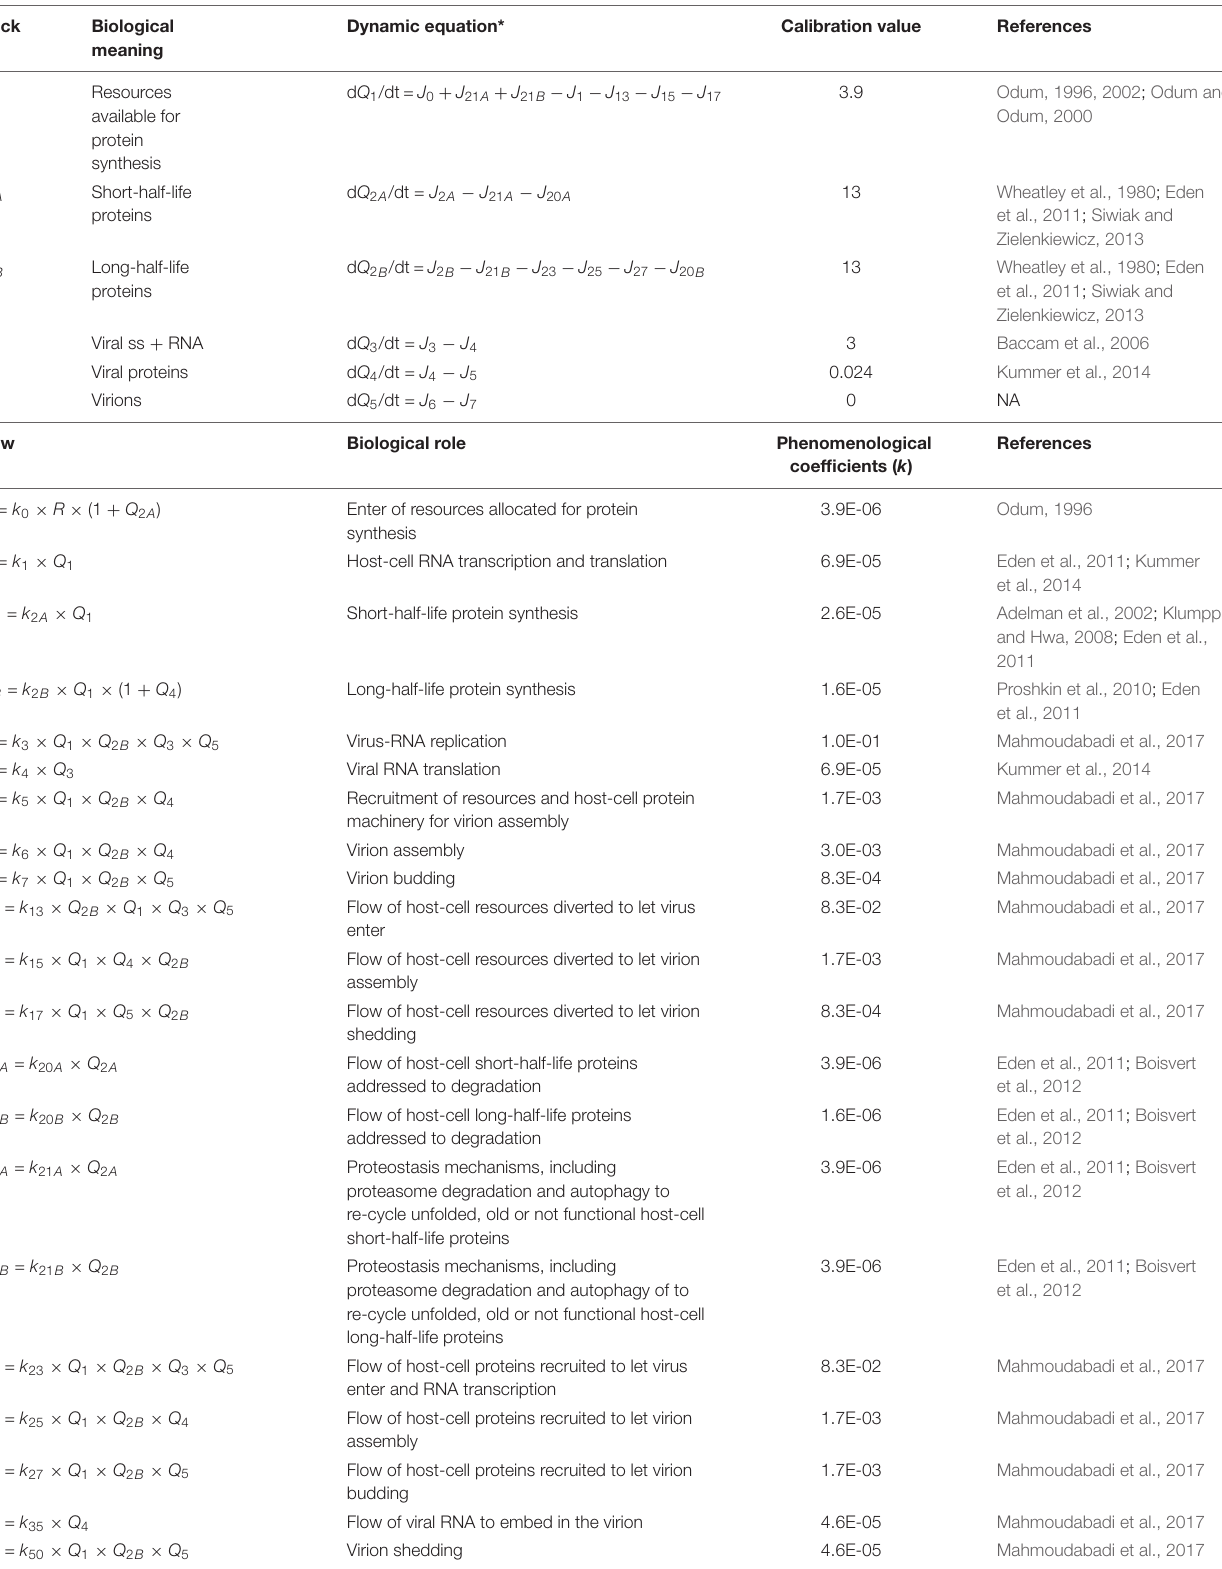
TABLE 1 | Inventory of stocks and flows depicted in the diagram of Figure 1 .